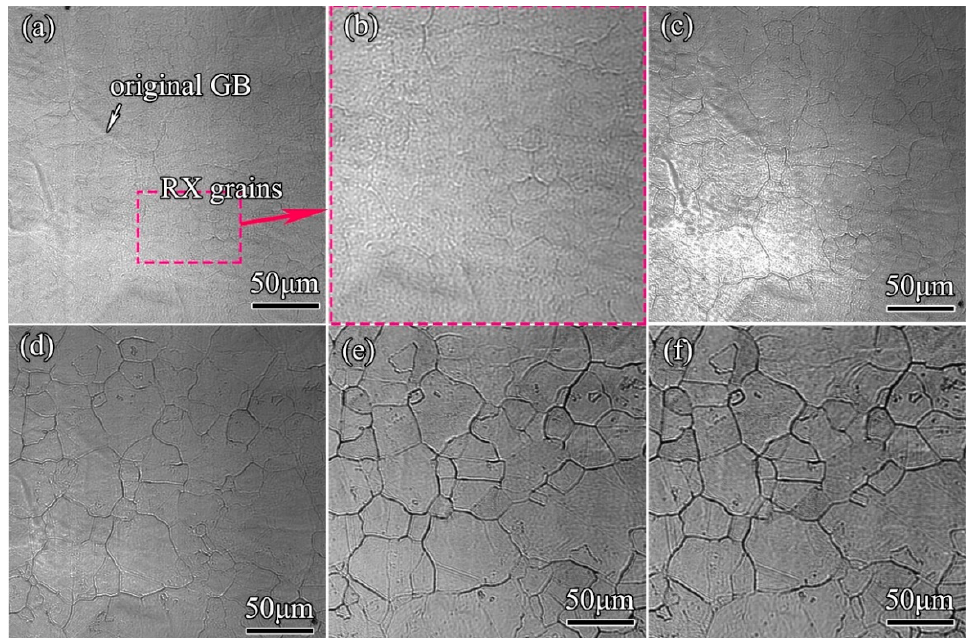
Figure 4. In situ observation results showing the microstructure evolutions of 300M steel heated at 16.7 °C/s to 1000 °C, and then isothermal held for ( a ) 240 s; ( c ) 266 s; ( d ) 316 s; ( e ) 523 s; and ( f ) 713 s. The zoomed view of ( a ) was shown in ( b ). The “GB” and “RX” denote “grain boundary” and “recrystallized”, respectively.